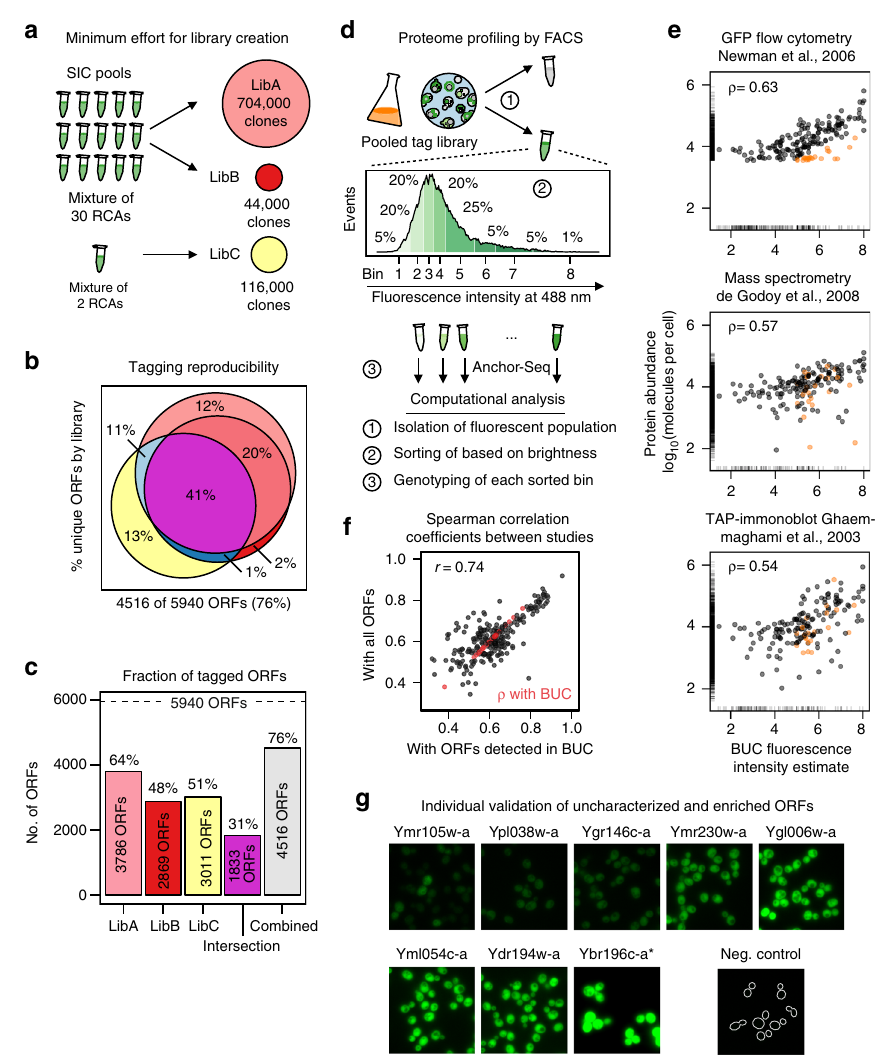
Fig. 5 Creating and screening large CRISPR-Cas12a (Cpf1)-assisted tag library engineering (CASTLING) libraries. a Three libraries with different numbers of collected clones were generated from self-integrating cassette (SIC) pools combining either 2 or 30 recombineering reactions to investigate the minimum effort for a proteome-wide (design: 5940 open-reading frames (ORFs), oligonucleotide pool D, Supplementary Table 2) CASTLING library (details in Methods). b Venn diagram of genotypes recovered in each of the three libraries; all libraries combined tagged 4516 different ORFs. c Genotype diversity in each of the three libraries, shared between them, or after their combination. d Proteome pro fi ling by fl uorescence intensity of a non-exhaustive mNeonGreen tag library (library #1.1, Fig. 4c, Supplementary Table 2) using fl uorescence-activated cell sorting (FACS). After enriching the fl uorescent sub- population of the library and determining the fold enrichment of each genotype by next-generation sequencing (NGS), this sub-population was sorted into eight bins according to fl uorescent intensity. Analysis of each bin by Anchor-Seq and on-site nanopore sequencing allowed the assignment of an expected protein abundance for each genotype. e Pairwise comparisons between fl uorescence intensity estimates calculated from genotype distribution across all bins (Methods, Eq. 2; this study denoted as BUC) and protein abundances reported by selected genome-scale experiments 4,39,40 normalized to molecules per cell 38 . Outliers (orange) were determined based on the comparison to a green fl uorescent protein (GFP) tag fl ow cytometry study 39 . Spearman ’ s correlation coef fi cients ( ρ ) are given. Marginal lines indicate abundance estimates only present in the respective study but missing in the other. f Comparison of Spearman ’ s correlation coef fi cients between studies either considering their overlap in detected ORFs or only the overlap with the 435 ORFs we could detect in this experiment. A Pearson ’ s correlation coef fi cient ( r ) is given. g Eight genes that had not been characterized in other genome- scale experiments 38 were tagged individually to verify whether fl uorescence intensity corresponded with their predicted characterization by FACS. Same exposure time for all fl uorescent microscopy images except for Ybr196c-a, which was imaged at 10% excitation; scale bar 10 µ m. b , c , e Source data are provided as a Source Data fi le